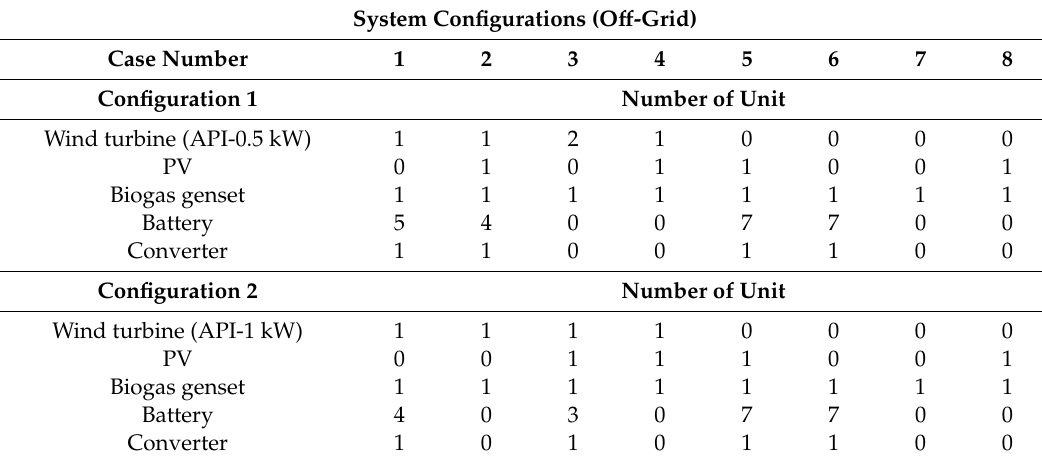
Table 3. Two configurations of the hybrid